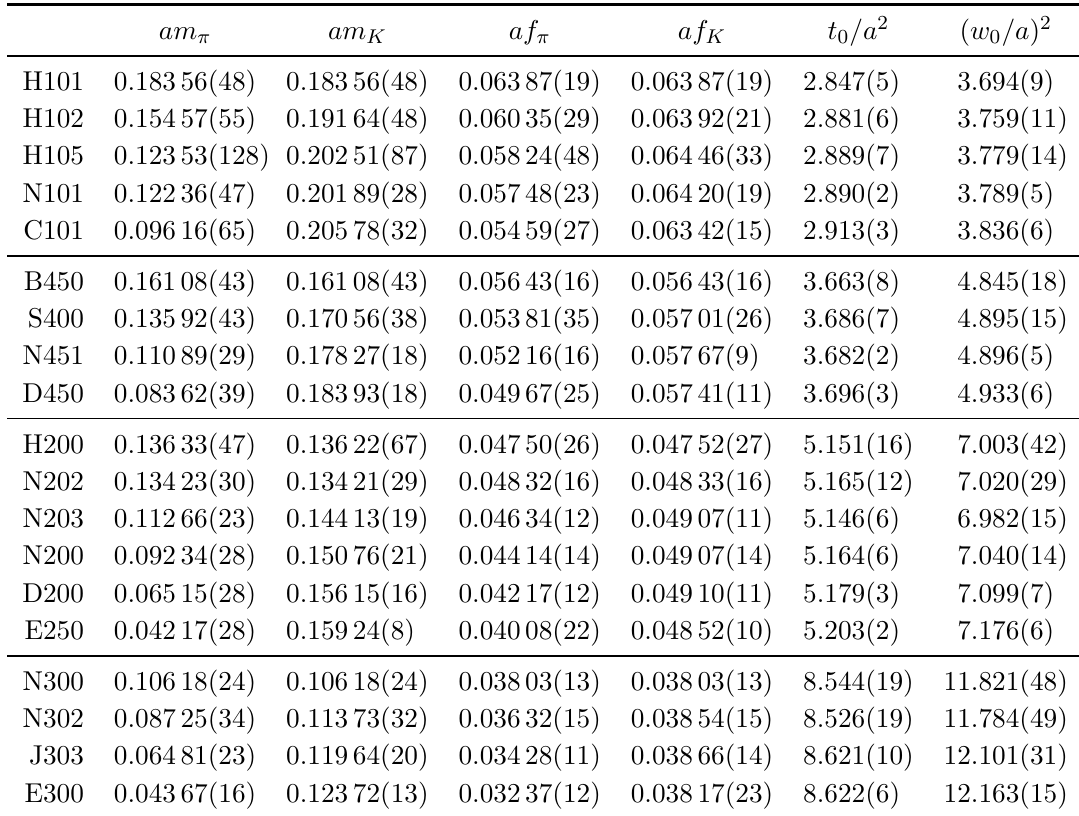
Table 8 . Meson masses and decay constants, and reference scales t 0 and w 2